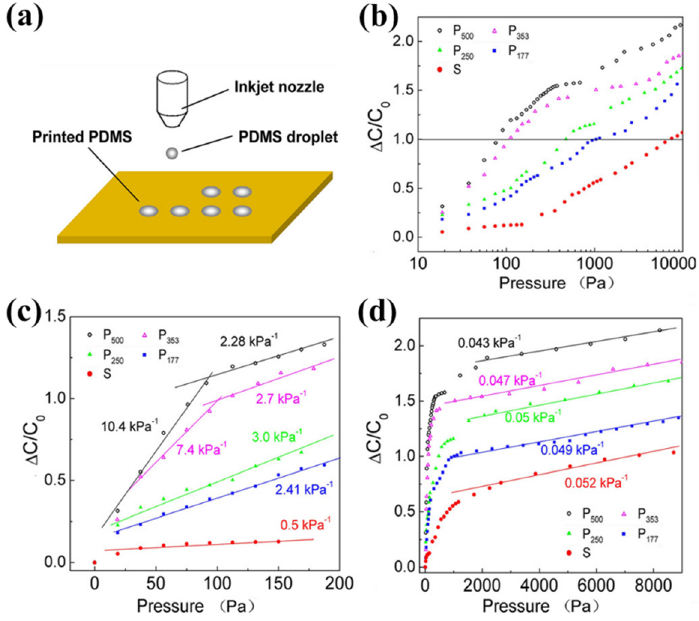
Figure 6. Inkjet printing-based microstructured PDMS. ( a ) Schematic diagram of inkjet-printed PDMS droplet and ( b – d ) the capacitance change ratio of the sensor with respect to pattern distances under pressure range of 0–10 kPa, 0–200 Pa, and 2–8 kPa, respectively. Reproduced with permission from [125], Copyright (2017), AIP publishing.